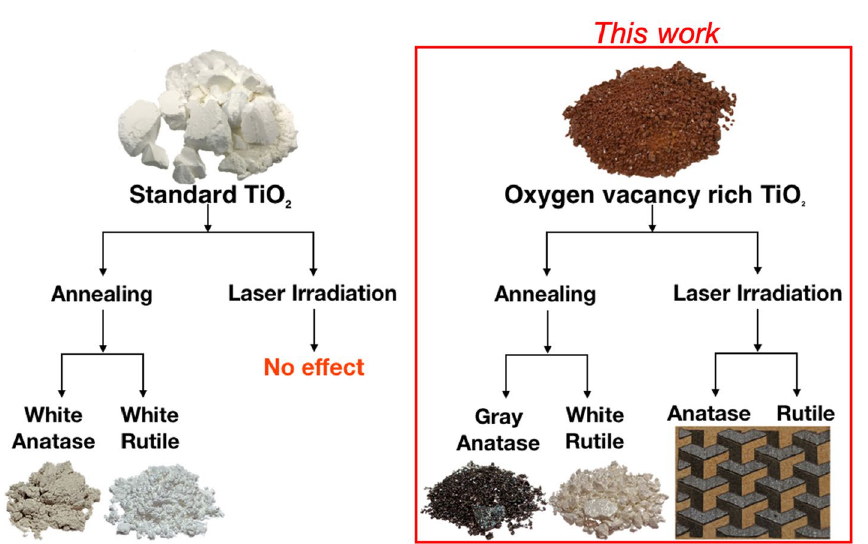
Figure 5. Comparison of the different crystallization processes for the standard (white) and oxygen vacancy- rich (red) amorphous TiO 2 powders using thermal-annealing and laser-induced